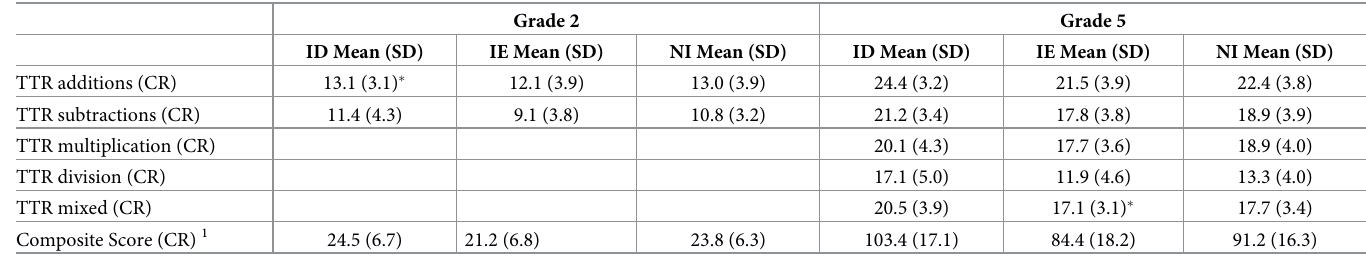
Table 7. Means (Standard Deviations) for the arithmetic task administered by